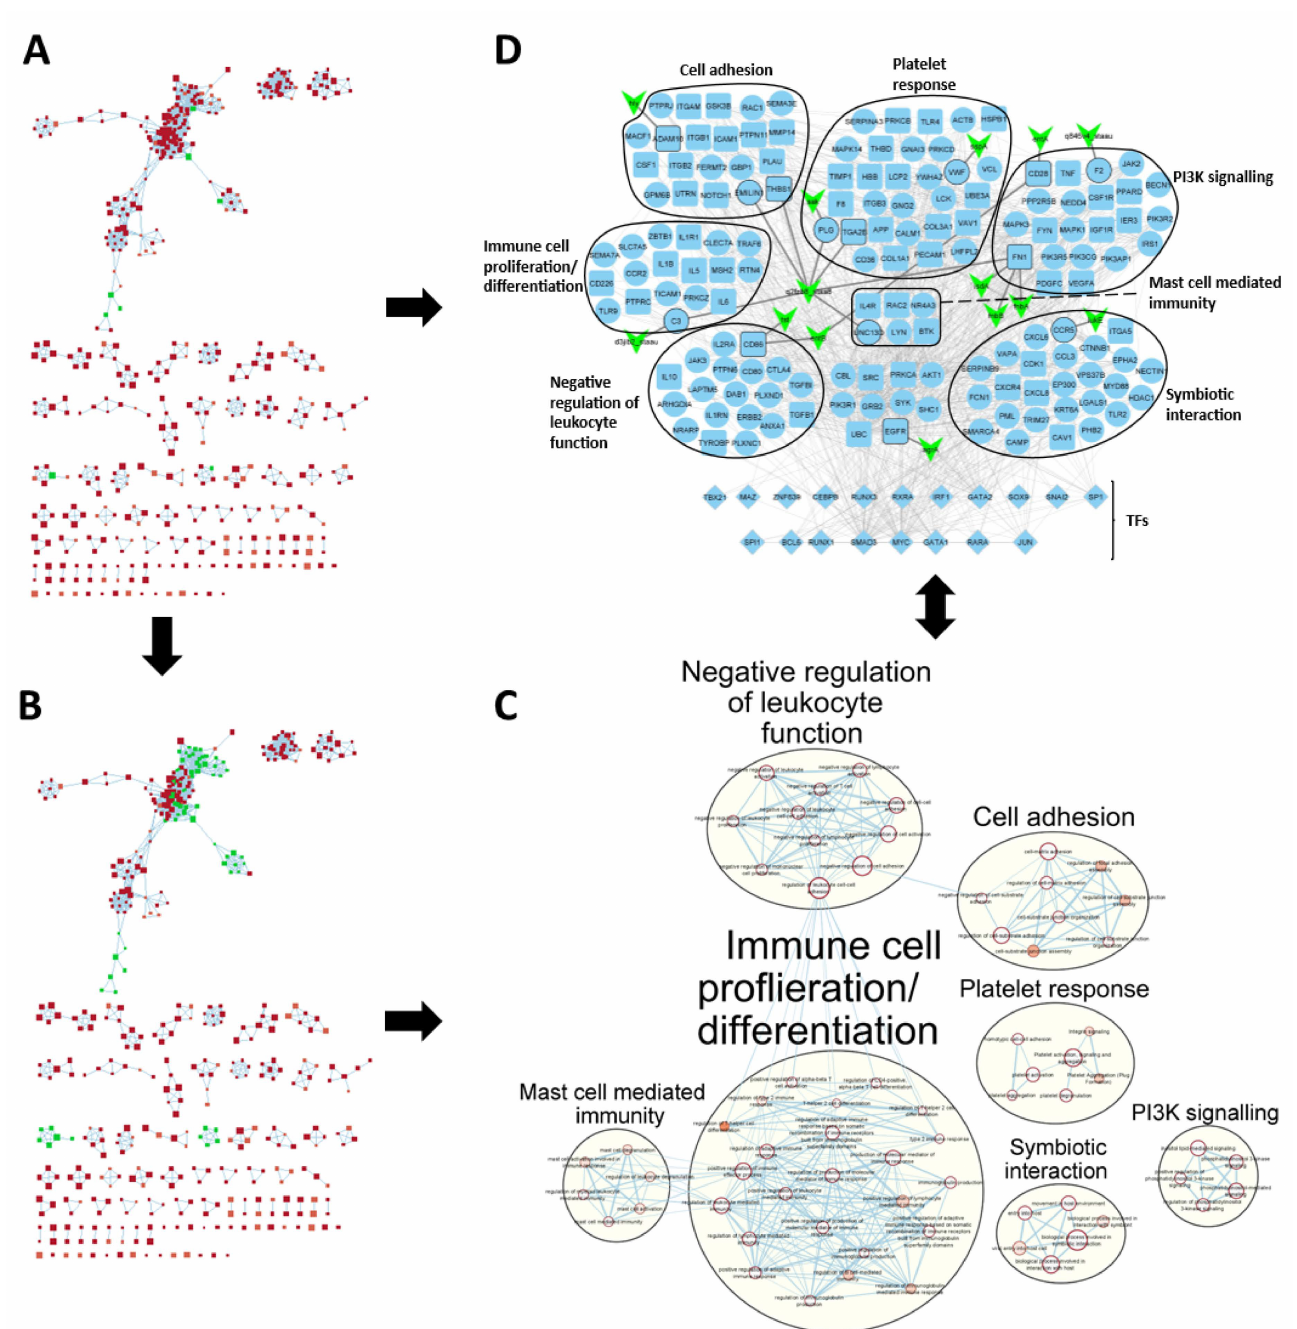
Figure 3. Generating the SA-PR3+ AAV interaction network from the disease network. ( A ) Network of significantly enriched biological processes/pathways (red nodes) in disease network genes. Edges represent shared genes between terms. Highlighted in green are the terms with the highest number of SA interacting genes. Disease network genes associated with the highlighted terms made up a subnetwork shown in ( D ). ( B ) To find terms related to those affected by interactions with SA, the direct neighbours of the highlighted nodes were selected and subsequently coloured green. The highlighted terms in ( B ) were clustered and labelled in ( C